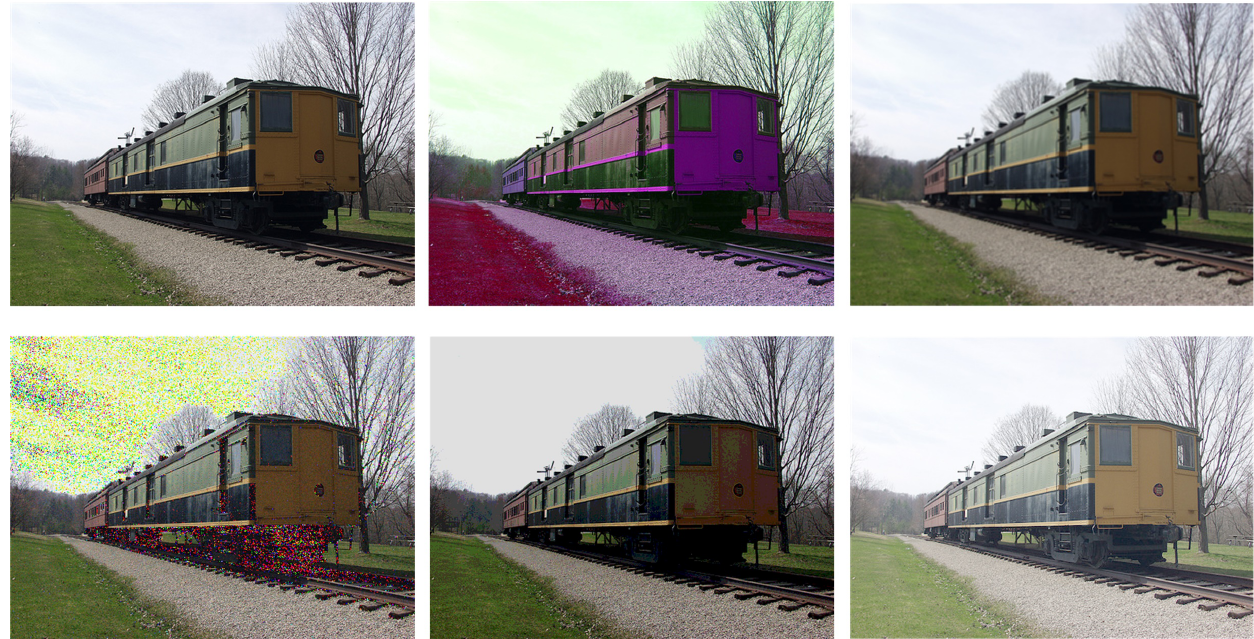
Figure 2. The image on top-left corner is a natural image from the ImageNet dataset [49]. The remaining five images, from left to right and from top to bottom, are five modified versions of the NI, after applying, respectively, color jitter, Gaussian blurring, noise addition, pixel value quantization (separately in RGB channels), and Gamma